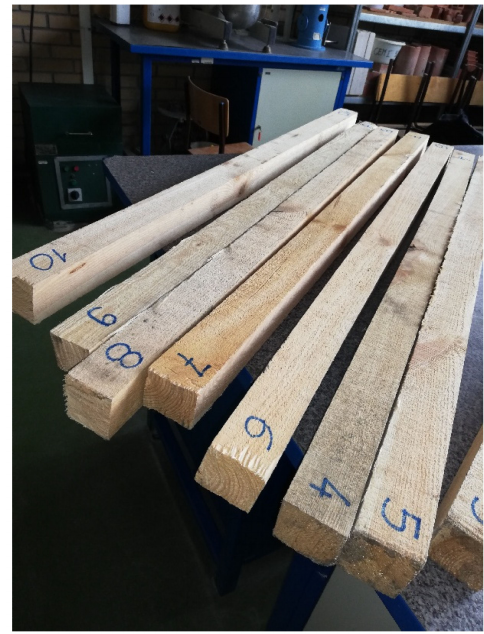
Figure 3. Pine wood elements.